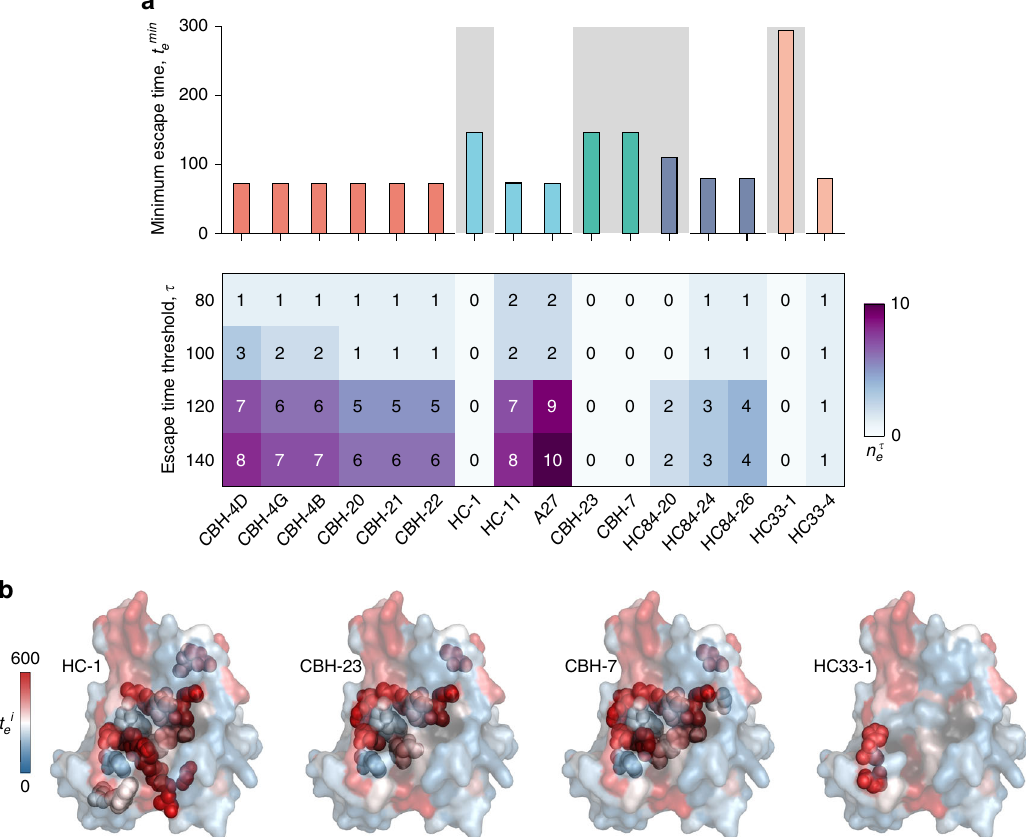
Fig. 4 Analysis of relative escape times associated with mutating the binding residues of known HmAbs identi fi es potential dif fi cult to escape HmAbs. a Minimum escape time across all residues t min e (top panel) and number of residues with relatively short escape times n τ e (bottom panel) in the binding residues of 16 HmAbs, determined using global alanine scanning 38 . The binding residues of the HmAbs are de fi ned as the mutations that resulted in reduction of binding with respect to the wild-type to ≤ 20%. HmAbs are colored according to the antigenic domains using the scheme in Fig. 3b. The background of the HmAbs predicted to be relatively escape-resistant ( t min e > ζ ) is shaded. b Location of binding residues of four HmAbs identi fi ed as relatively escape-resistant are shown as spheres on the available crystal structure (PDB ID 4MWF 43 ). Heat map shows the escape times ( t i e ) associated with incurring mutations at antibody-binding residues similar to Fig.